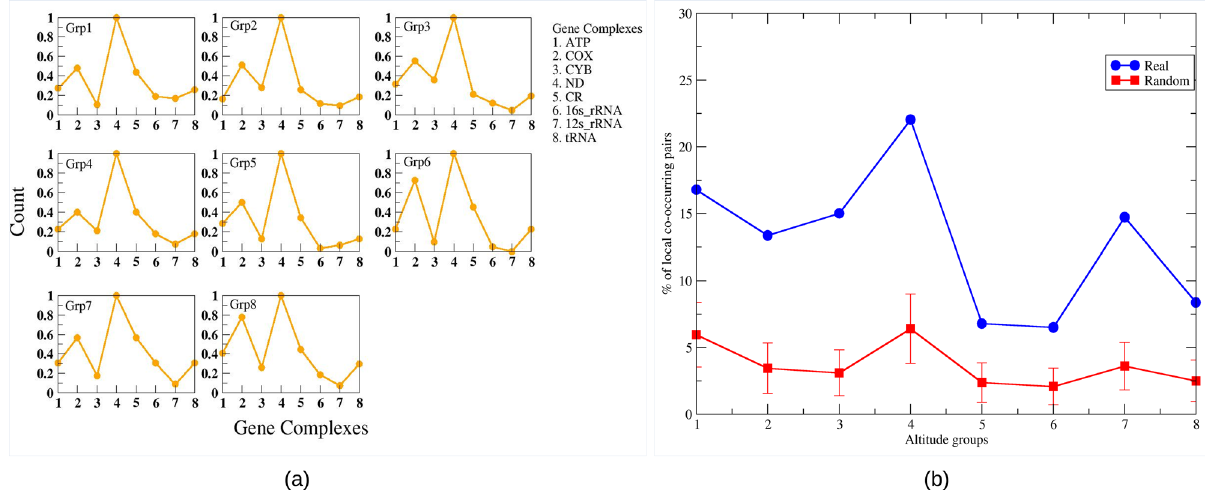
Figure 5. ( a ) The local nodes were mapped to genes and gene counts were plotted. Each gene was showing a similar count in each altitude. ( b ) The percentage of co-occurrence pairs consisting only of local